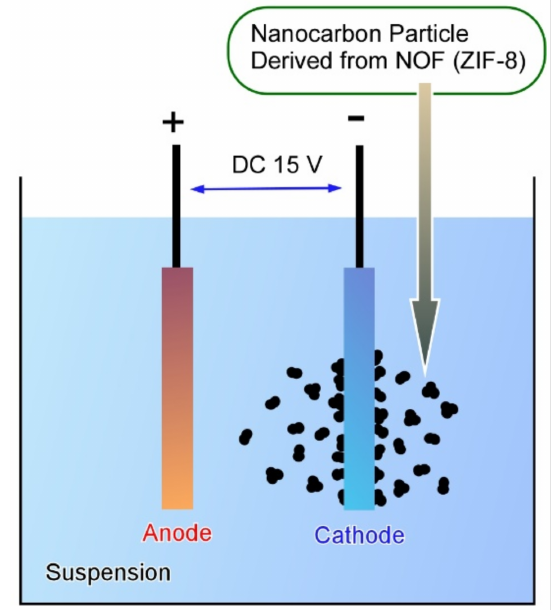
Figure 5. Fabrication of the flexible micro-supercapacitor electrodes using nanocarbon films derived from the zeolitic imidazole-based metal-organic framework